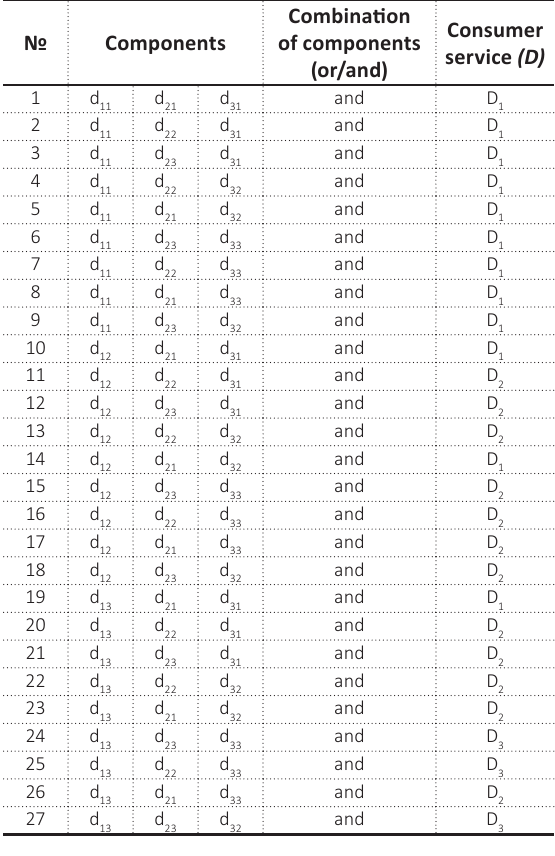
Table A8. Rules for forming a consumer service